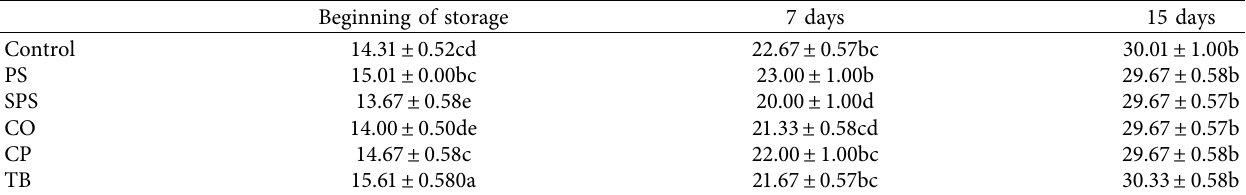
Table 3: Effect of okra gum and different starches on whey separation of yogurt at the beginning of storage, after 7 days, and 15 days.